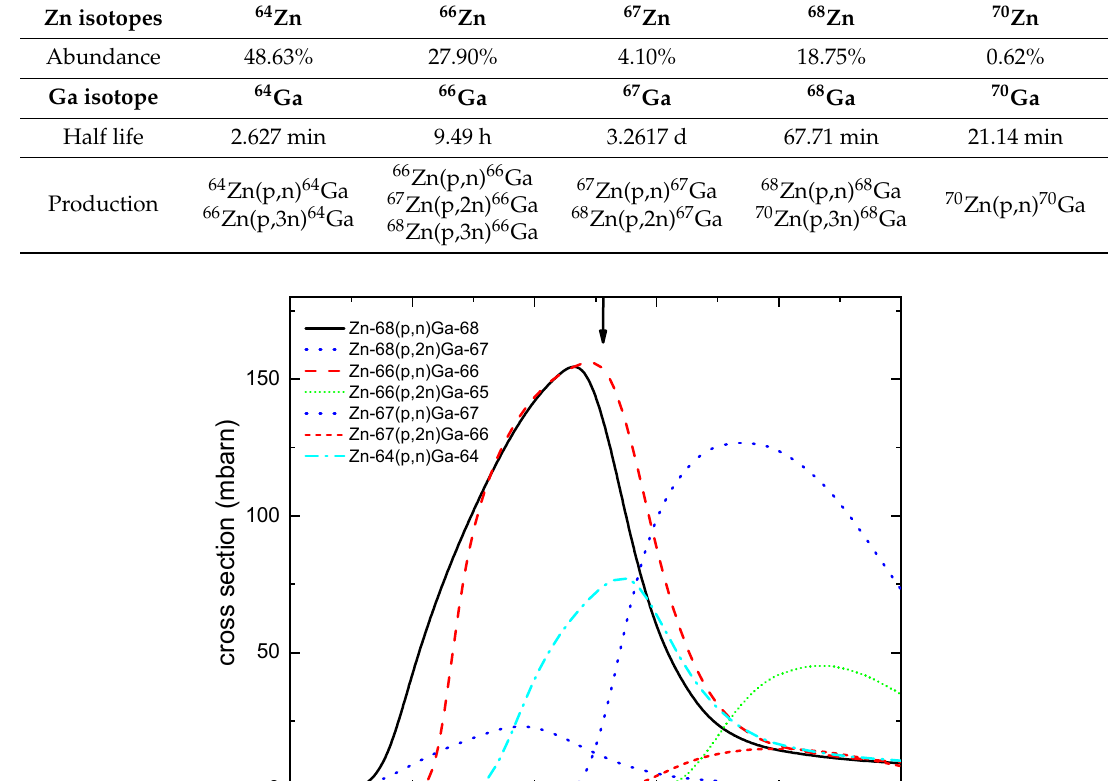
Table 1. Natural abundance of zinc isotopes [9] and produced gallium isotopes. Half-lives from [10].